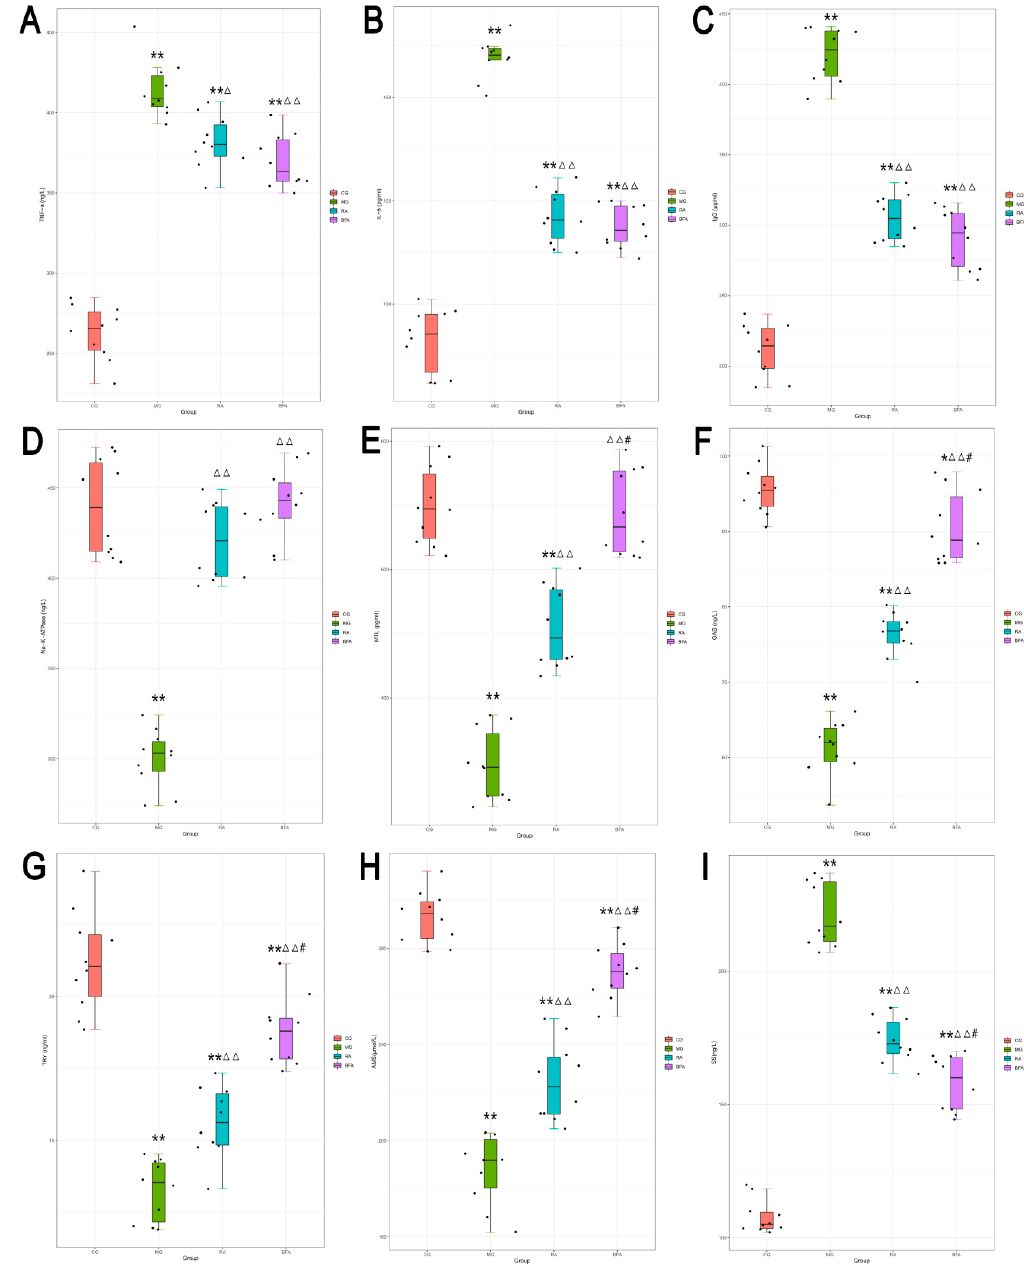
Figure 2. Comparison of the serum levels of biochemical indices among diverse groups: ( A ) Tumor necrosis factor- α (TNF- α ) level; ( B ) interleukin 6 (IL-6) level; ( C ) immunoglobulin G (IgG) level; ( D ) Na ＋ /K ＋ -ATPase level; ( E ) motilin (MTL) level; ( F ) gastrin (GAS) level; ( G ) trypsin (TRY) level; ( H ) amylase (AMS) level; and ( I ) somatostatin (SS) level. Values are presented as box-plots, of which the black spots are the individual data points of each group ( n = 10). Differences were assessed by ANOVA. * P < 0.05, ** P < 0.01 when compared with the control group (CG); △ P < 0.05, △△ P < 0.01 when compared with the model group (MG); # P < 0.01 when compared with the raw Atractylodis Rhizoma group (RA).